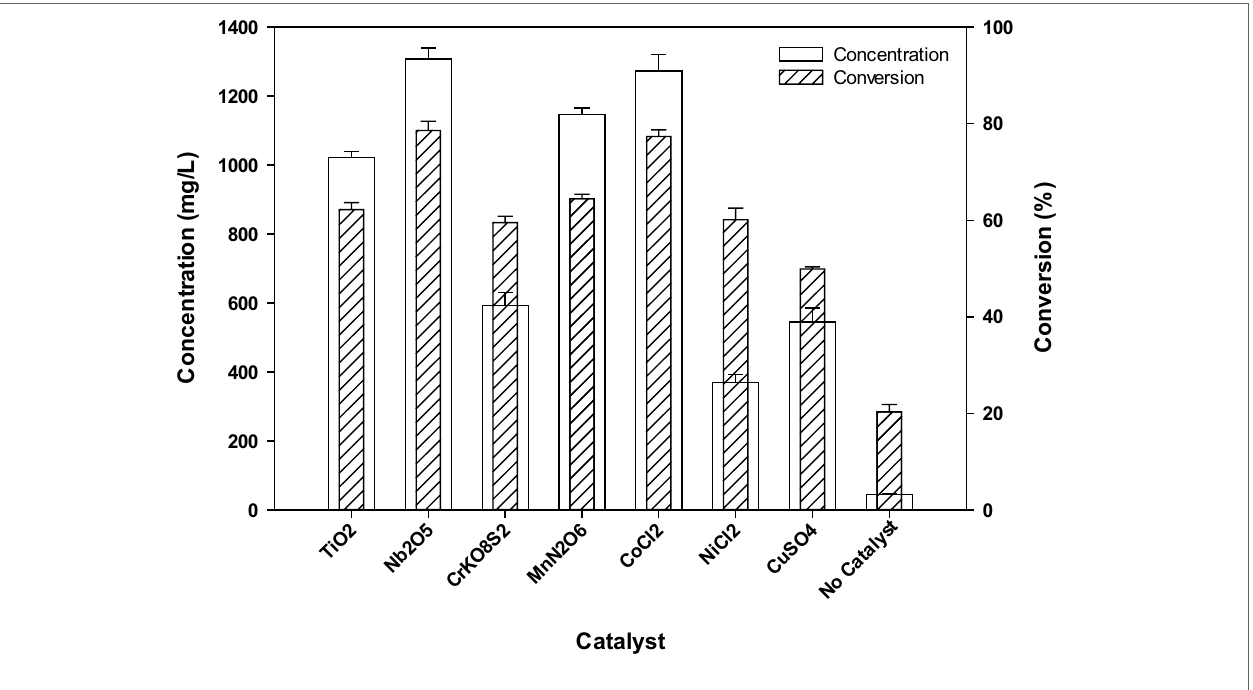
FigUre 1 | Screening of transition metal